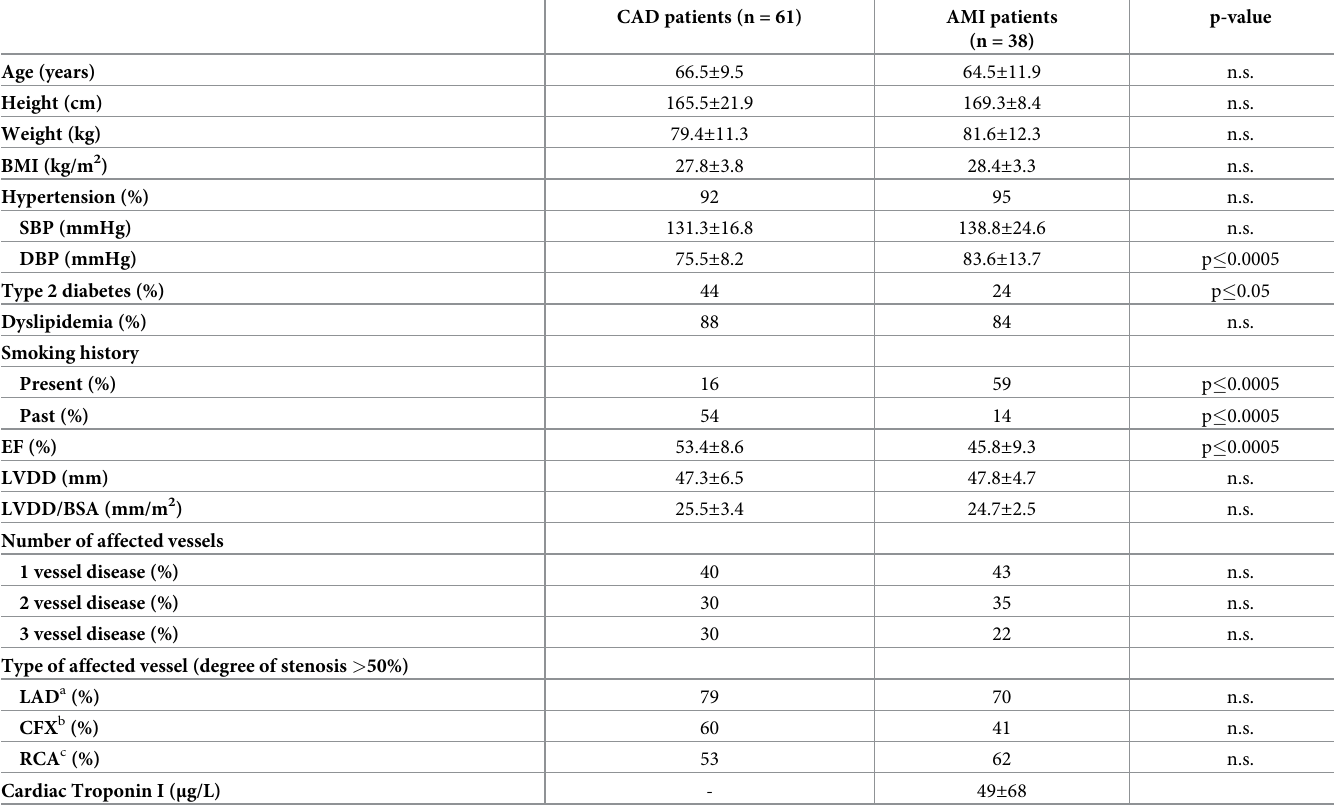
Table 1. Clinical characteristics of CAD and AMI